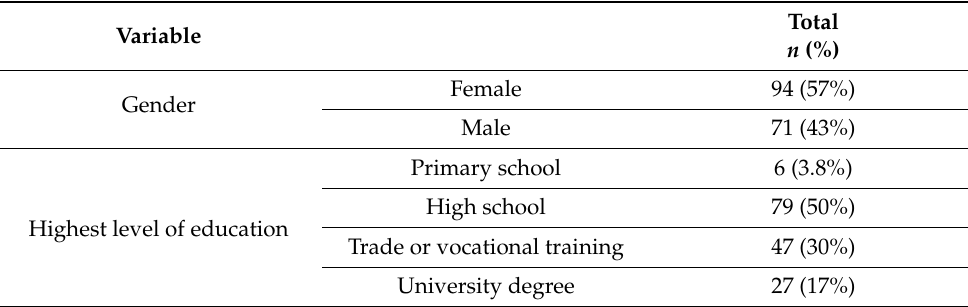
Table 1. Participant sociodemographic and disease characteristics ( n =